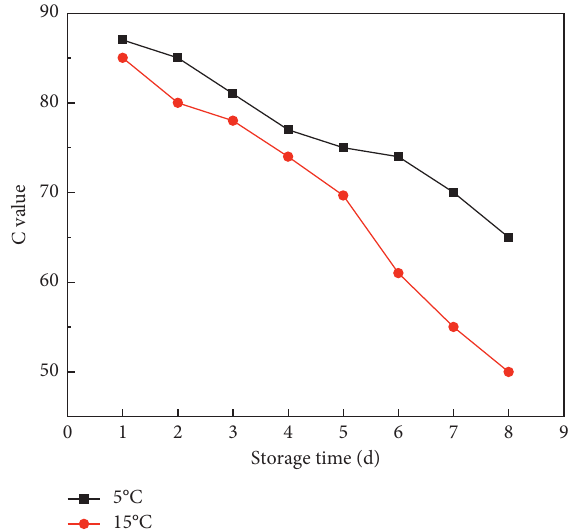
Figure 2: Color difference analysis results of potato seedlings. (a) Color change curve of potato seedlings.